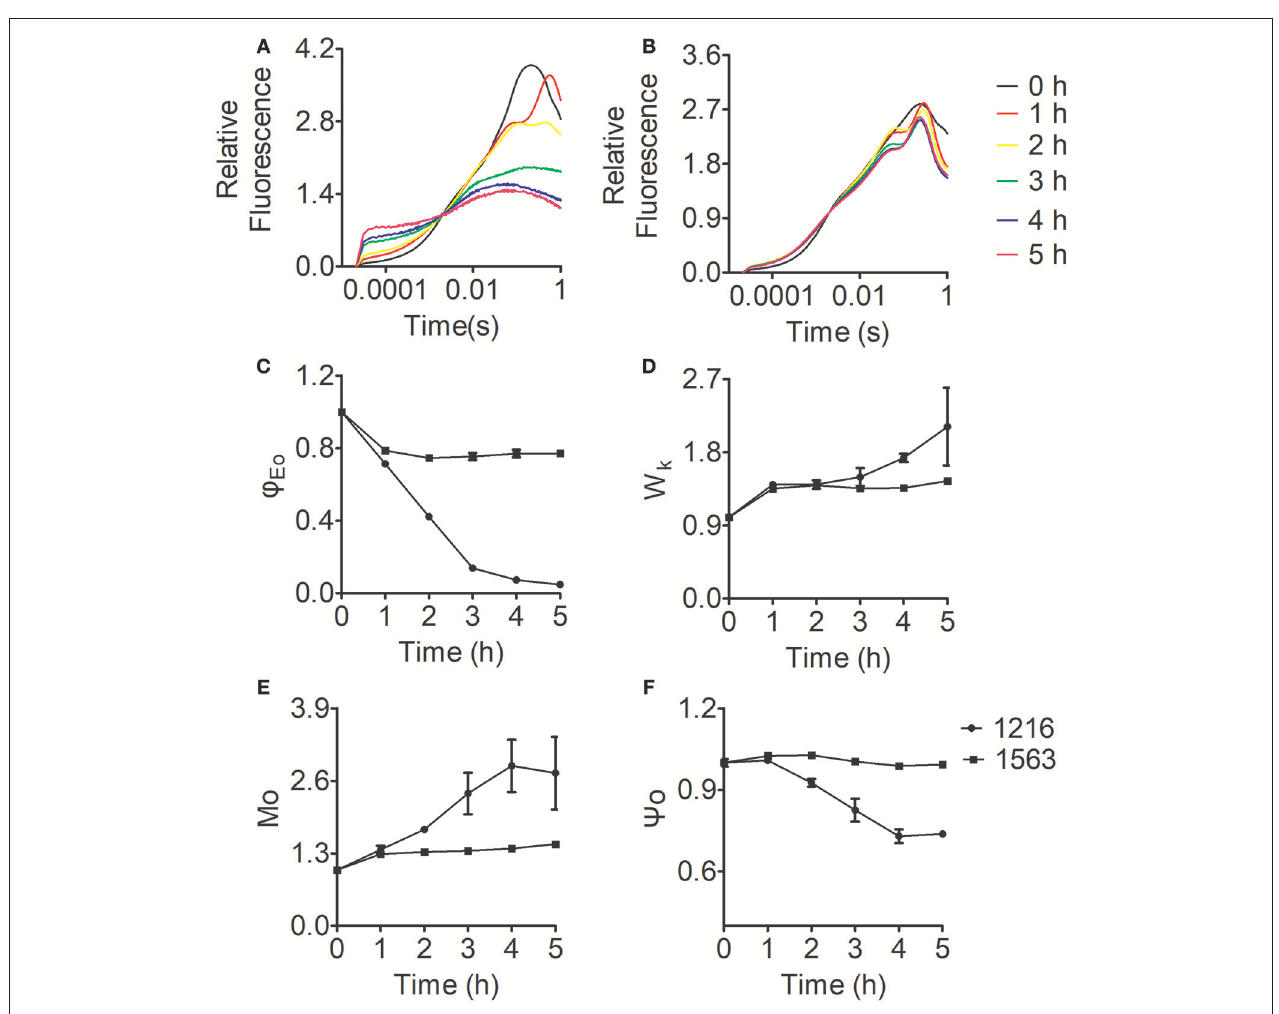
FIGURE 9 | Relative variable fluorescence and JIP-test parameters of Chlorella FACHB-1216 and FACHB-1563 cultured in BG11 and 1g L − 1 NH 4 Cl. (A,B) Represent Chlorella strain FACHB-1216 and FACHB-1563, respectively. (C–F) Represent Mo, 9 o, φ Eo, and Wk, respectively. The control (0h) values were set to